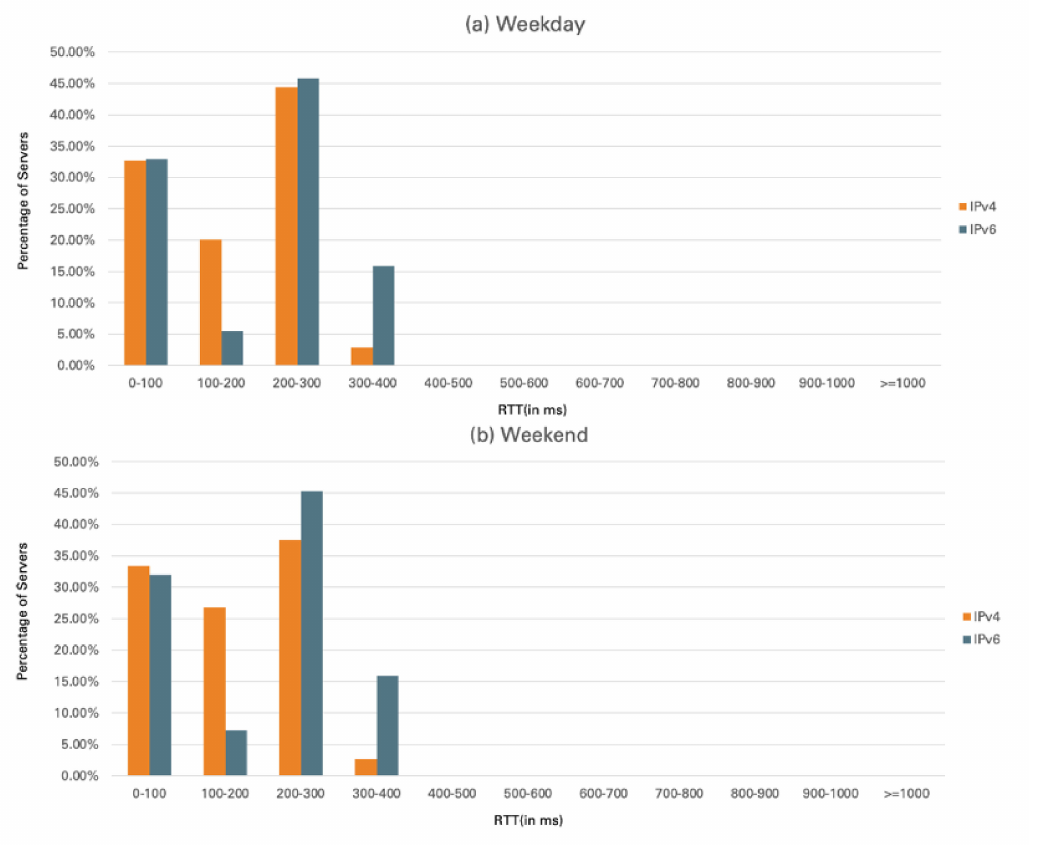
Figure 7. IPv4 vs. IPv6 RTT